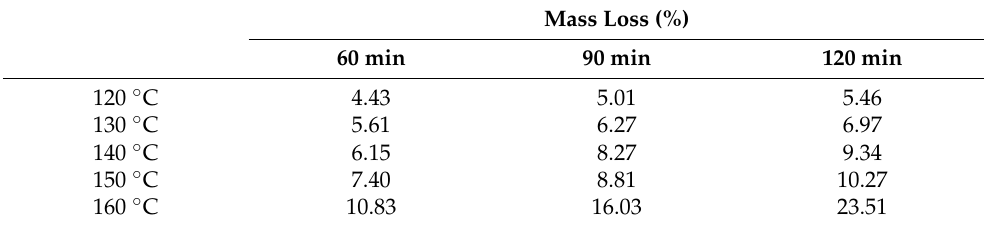
Figure 3. Influence of hydrothermal treatments on the main chemical composition of bamboo samples: ( A ) Cellulose; ( B ) Hemicellulose; ( C ) Lignin. Table 1. Mass loss of bamboo samples.